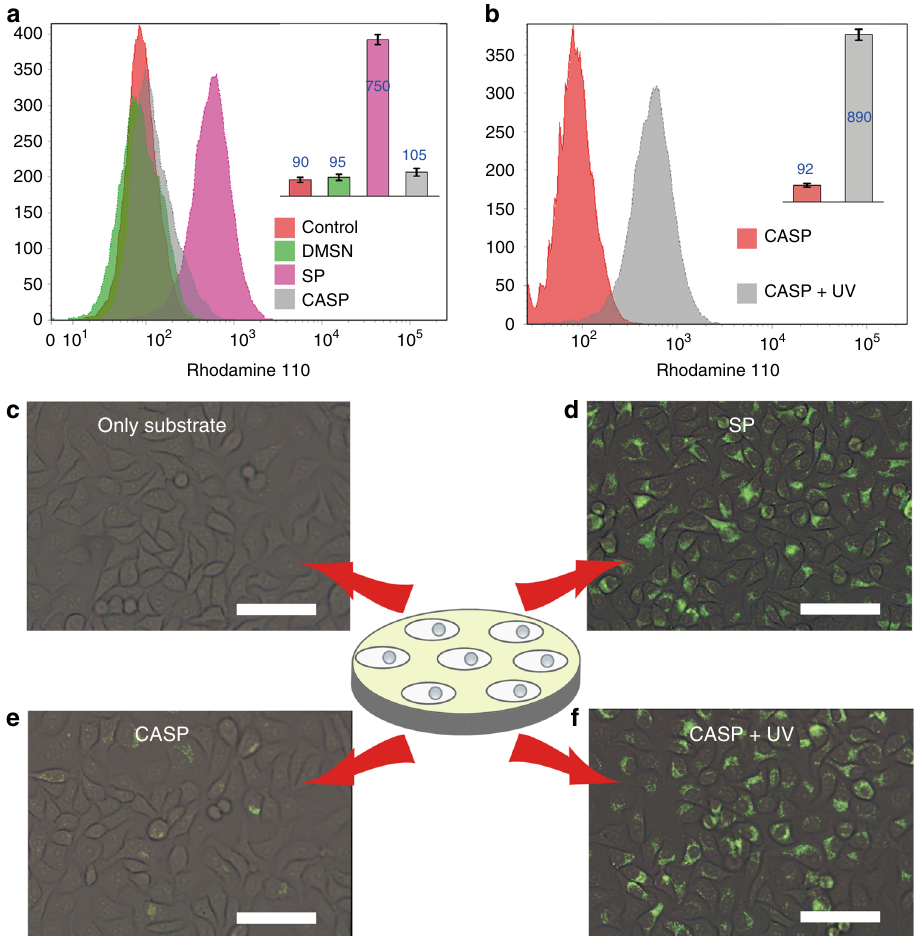
Fig. 3 Triggered cleavage of alloc-Rhodamine 110 ( 4 ) in living cells. a The fl ow cytometry analysis of control (cells alone), DMSN, SP, and CASP. b Treated the CASP with UV light, the cells produced an increased fl uorescence in the fl ow cytometry. c – f Fluorescence images of HeLa cells. A green fl uorescence was observed with SP ( d ) and CASP + UV light ( f ), while no fl uorescence was obtained with substrate only ( c ) and CASP ( e ) (scale bar = 50 µ m). Data were presented as mean ± s.d. ( n =